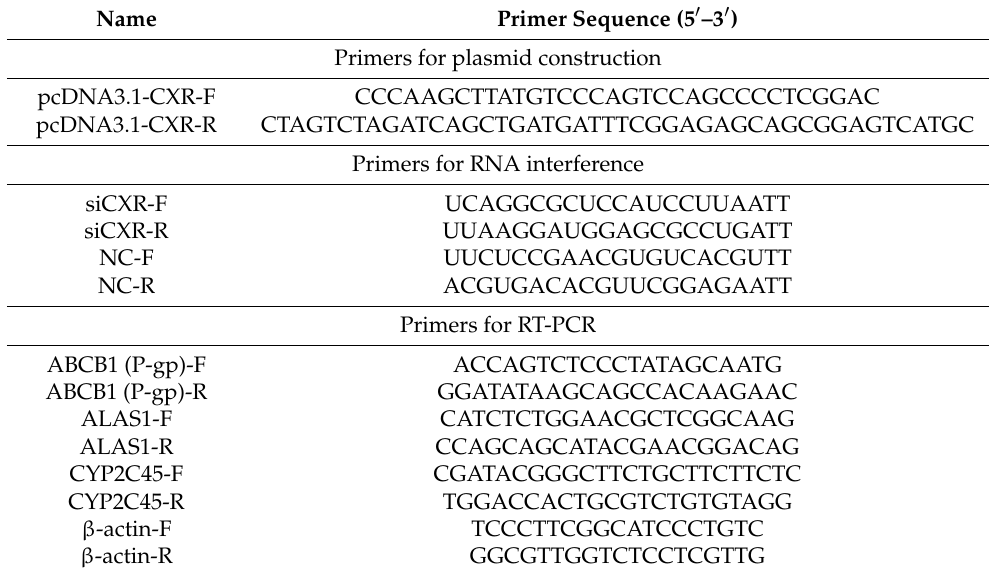
Table 2. Oligonucleotide sequences of